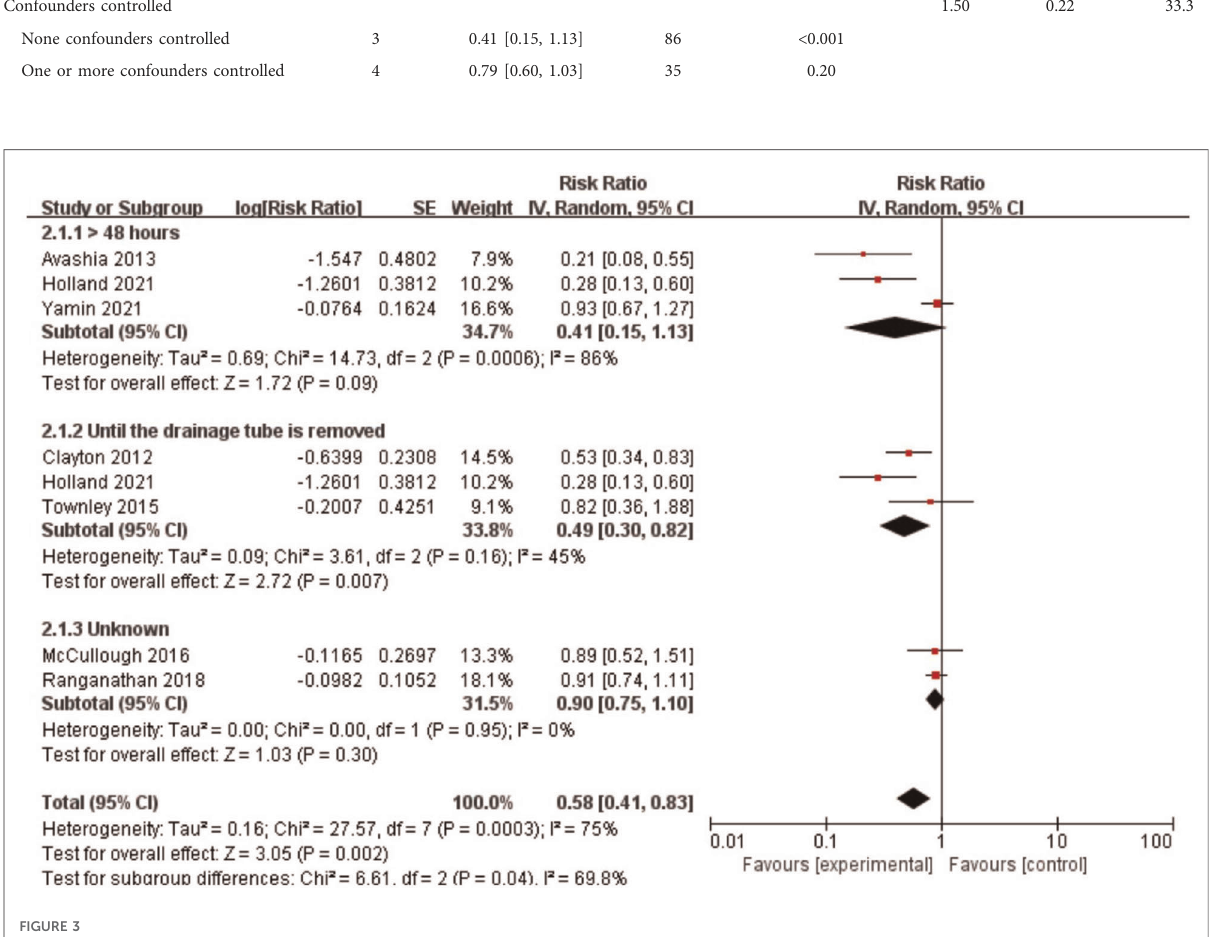
FIGURE 3 Forest plot for the subgroup of duration of postoperative antibiotic use and